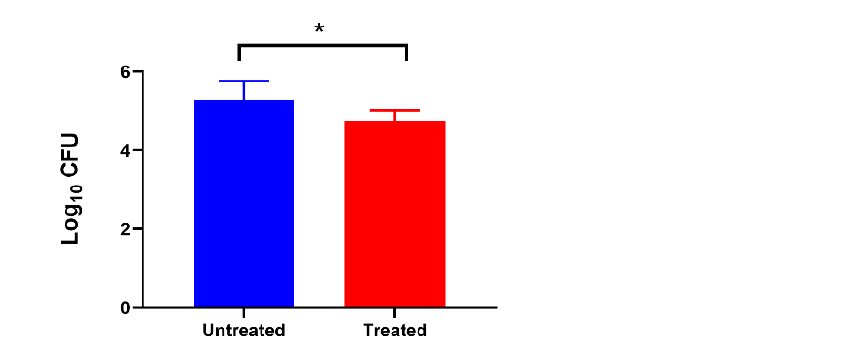
Figure 5. Effect of ex-c-di-GMP on adhesion of C. jejuni to Caco-2 cell. Inhibition of cell adhesion in the presence of 200 µ M ex-c-di-GMP. Data are presented as mean ± standard error (3 or more biological repeats) and were analysed using two-tailed Student’s t -test. The asterisk (*) indicates a statistically significant difference compared to the untreated control ( p < 0.05).